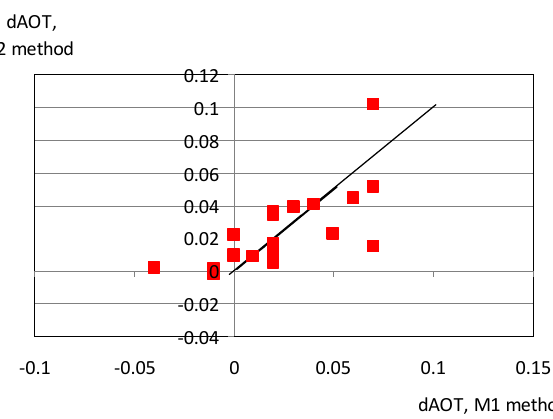
Fig. 2. Comparison between Zvenigorod and Moscow simultaneous Fig.2. Comparison between Zvenigorod and Moscow simultaneous AOT500 measurements. AOT500